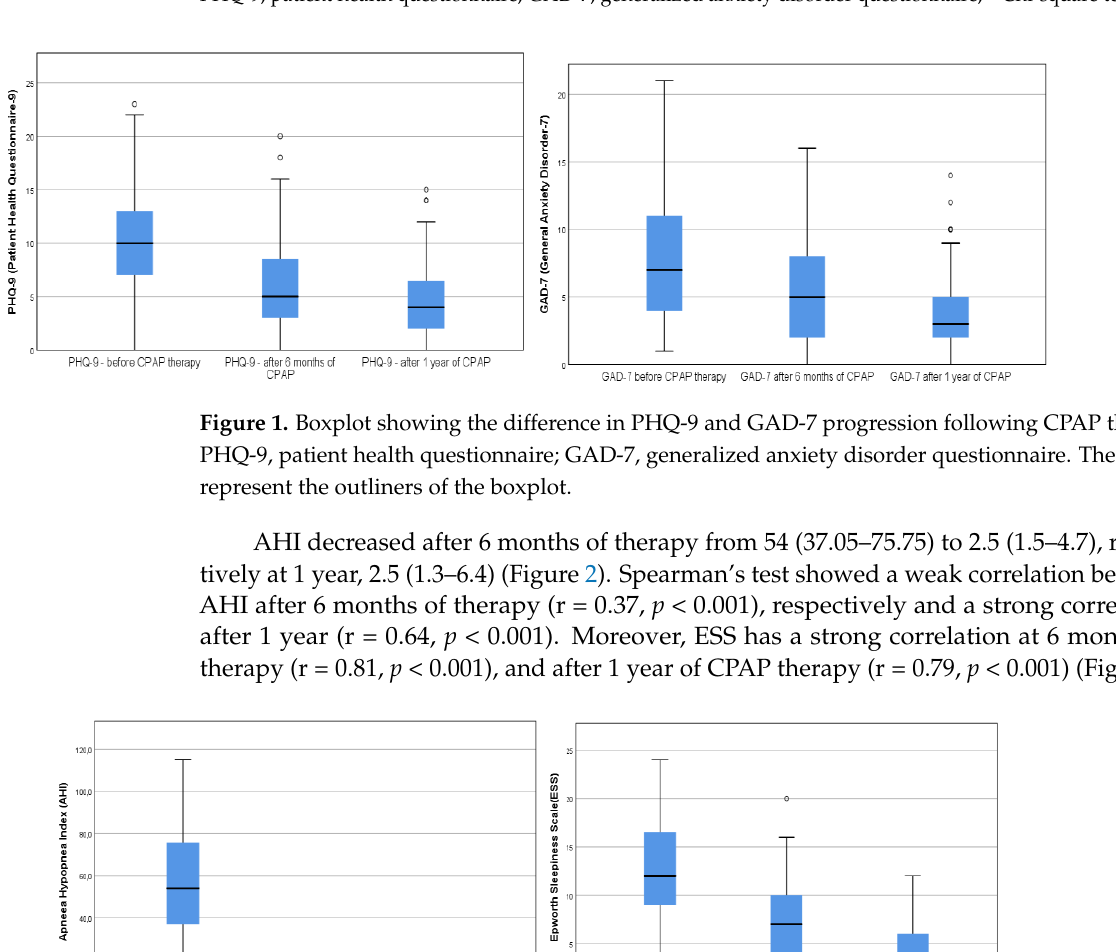
PHQ-9, patient health questionnaire; GAD-7, generalized anxiety disorder questionnaire; 1 Chi-square test.